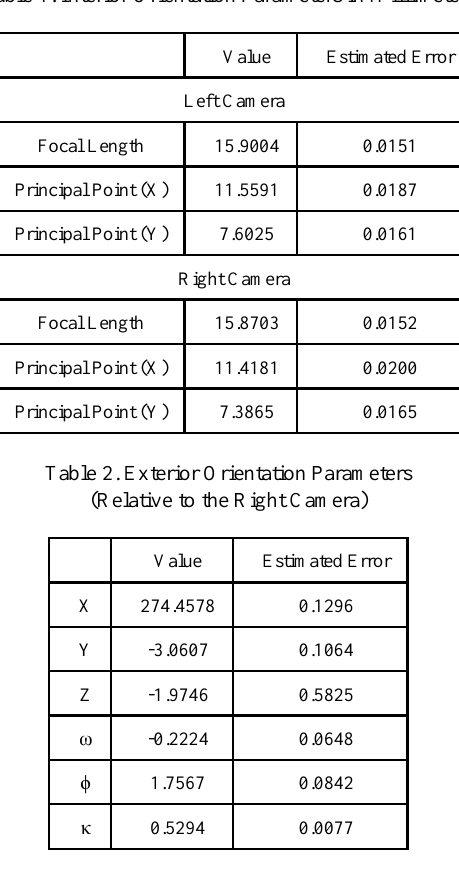
Table 1. Interior Orientation Parameters in Millimeters